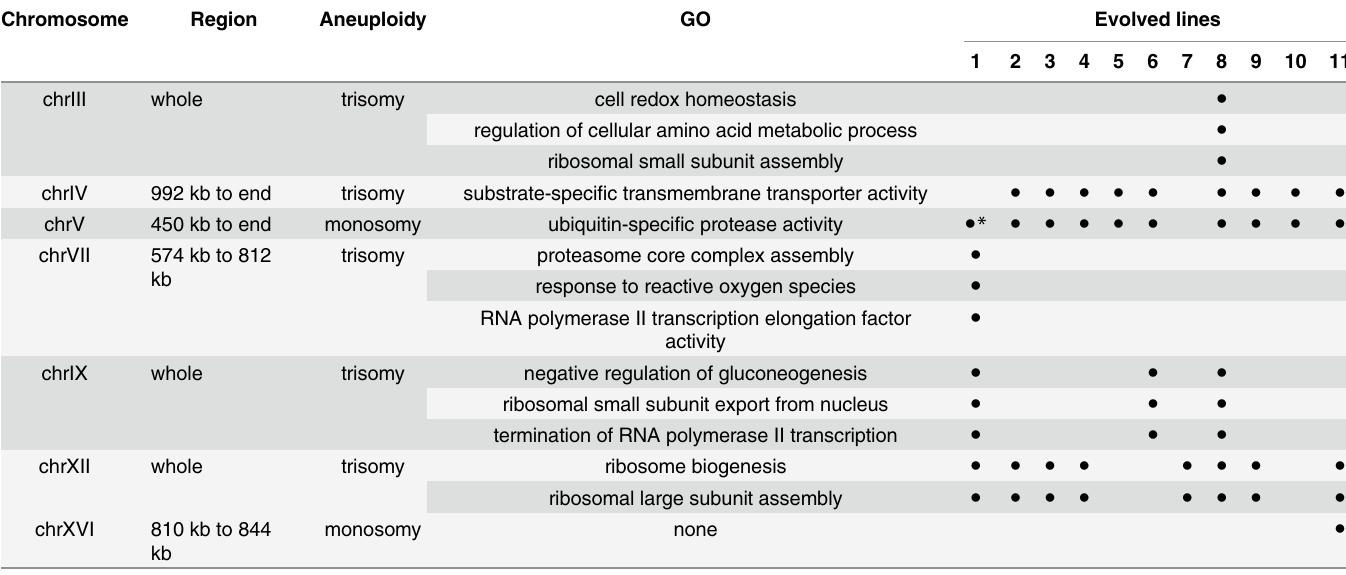
The affected chromosomes, the extent, the direction of the changes, and biological processes that are enriched signi fi cantly ( p < 0.05) in the regions are indicated. Functional enrichment analysis was done using FunSpec, a web-based cluster interpreter for yeast [23]. * indicates partial monosomy of chrV from 450 kb to 498